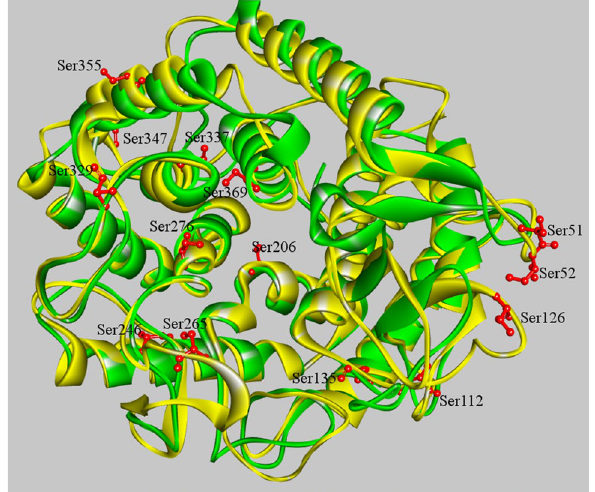
Figure 1. Comparisons of model structure of CsnTS and crystal structure of CelA. The model structure of CsnTS was constructed using the crystal structure of Chok (1V5C) as a template. The CsnTS was colored by yellow and the CelA was colored by green, respectively. The mutation sites in CsnTS were also displayed and represented by stick.